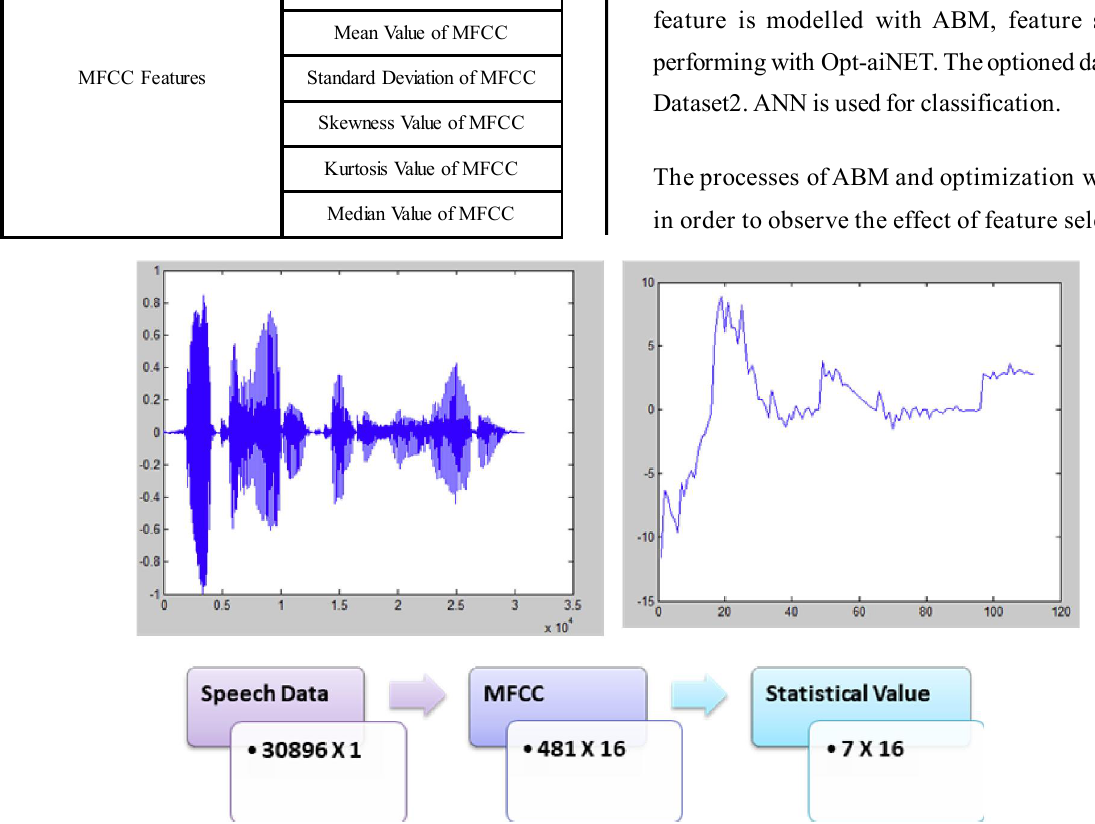
TABLE 1. THE STATISTICAL FUNCTIONS USED FOR MFCC